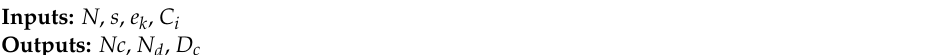
Table 5. Algorithm-1 to identify the optimal switching